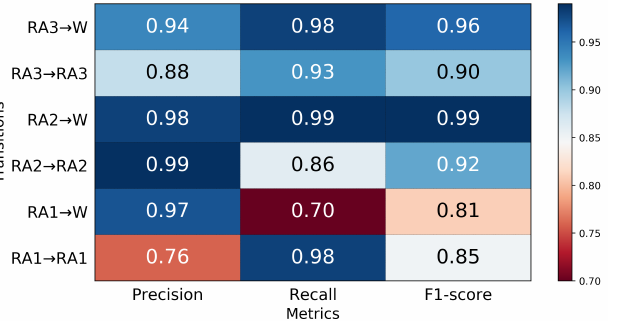
Figure 9. The precision, recall, and F1-score for transitions from ramp ascent 150ms prior to TO.